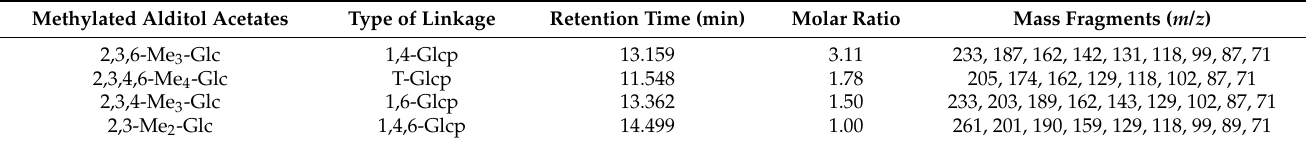
Table 1. Methylation analysis data of OFP.